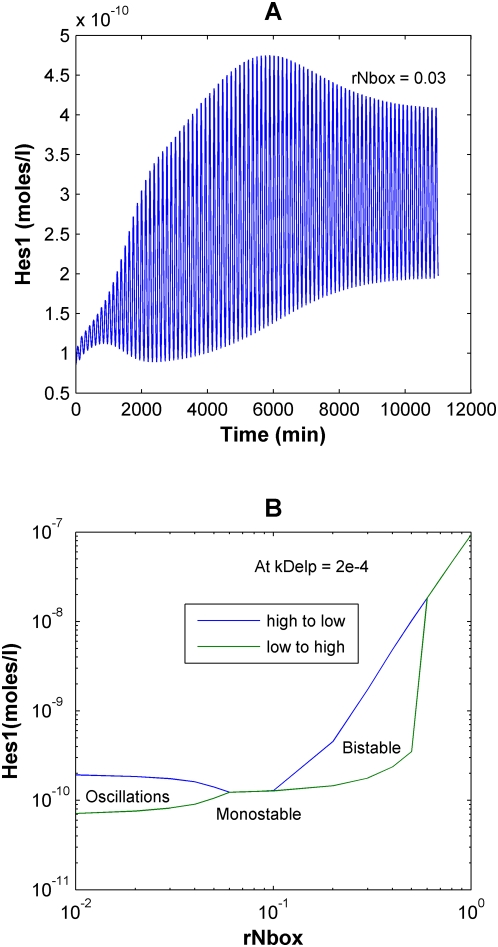
Effect of the repression constant of Hes1 (rNbox) on the Notch signaling network.(A) At lower values or rNbox (higher repression constants for Hes1), the network predicts oscillations in Hes1 levels. As the value of rNbox is decreased to 0.03 and lower, the system exhibits stable oscillations. (B) At a fixed Delta signal strength of kDelp = 2×10−4, as the rNbox is progressively decreased, the response of Hes1 transitions from behaving as a bistable switch to a brief region of monostability to an oscillator.